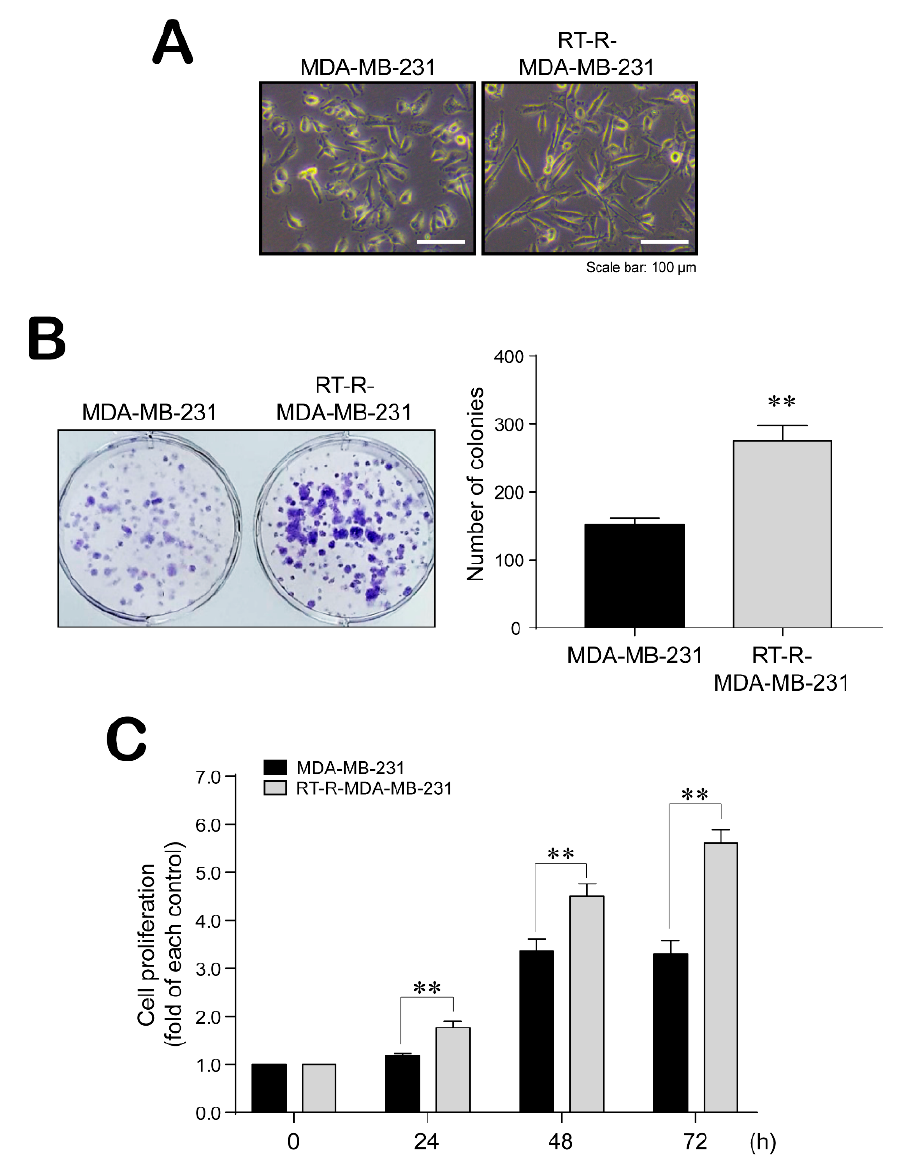
Figure 1. Radiotherapy-resistant (RT-R)-MDA-MB-231 cells showed morphological changes and enhanced colony formation and proliferation. ( A ) The morphologic changes of cells were observed under a light microscope (×200). ( B ) The colony formation assay was performed as described in the Methods. Cells were seeded at 10 3 cells in 6-well plates, and 10 days later, colonies were stained with 0.1% Giemsa staining solution. Data represent mean values ± SEM of three independent experiments. Significance compared with MDA-MB-231, ** p < 0.01. ( C ) Cells were seeded at 10 4 cells in 24-well plates and incubated for 24, 48, and 72 h. Cell proliferation was determined by 3-(4,5-dimethylthiazol-2-yl)-2,5-diphenyltetrazolium bromide (MTT) assay as described in the Methods. Data represent mean values ± SEM of three independent experiments. ** p < 0.01.